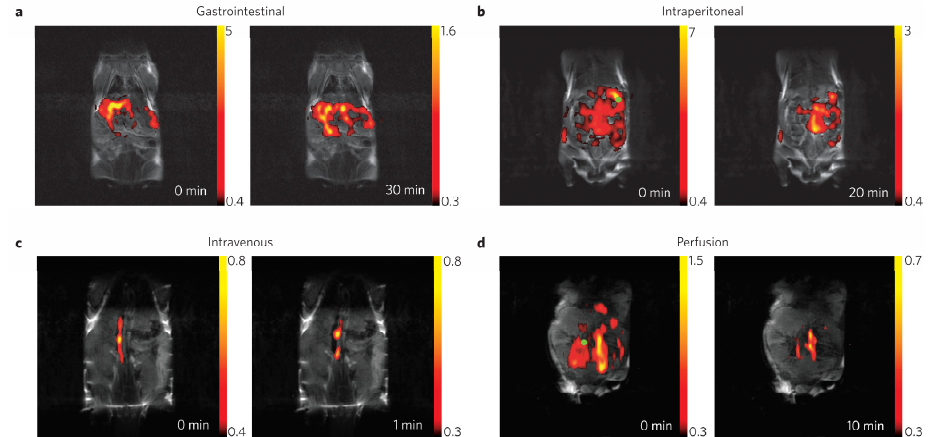
Figure 16. In vivo applications of 29 Si MRI using hyperpolarized Si MPs. ( a – c ) In vivo co-registered 1 H: 29 Si MRI of hyperpolarized Si particles administered intragastrically ( a ), intraperitoneally ( b ) and intravenously ( c ) via a tail-vein catheter. ( d ) Demonstration of perfusion imaging using 29 Si MRI of hyperpolarized Si MPs injected into the tumor of a prostate cancer (TRAMP) animal. In panels ( b ) and ( d ), the green circle shows the approximate location of the catheter. The color scale bars show 29 Si signal intensity in arbitrary units. (Reprinted by permission from Springer Nature [25], © (2013)). 2.2.6. Si Nanoparticles for Hyperpolarized MRI MRI of hyperpolarized nuclei was shown to provide a very high image contrast with little or no background signal [11]. To date, in vivo applications of pre-hyperpolarized materials have been limited by relatively short nuclear spin relaxation times. Si NPs were proposed as a new type of hyperpolarized MRI agent. Nuclear spin relaxation times for a variety of Si NPs were found to be extremely long, ranging from many minutes to hours at room temperature (Figure 17), allowing hyperpolarized NPs to be transported, administered and imaged on practical time scales [11]. Additionally, Si NPs can be surface functionalized using techniques common to other biologically targeted NP systems. These results suggest that Si NPs can be used as a targetable, hyperpolarized MRI agent (Figure 18) with a large range of potential